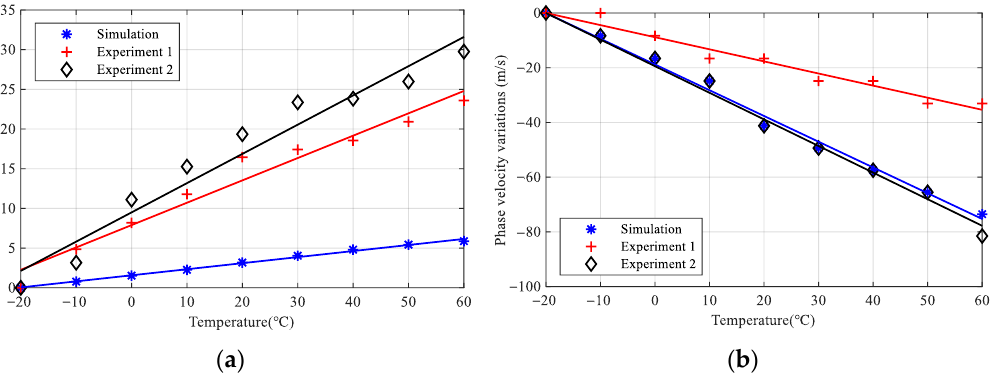
Figure 12. Comparison for variations of S 0 mode between simulation and experiment. ( a ) Variations of amplitude; ( b ) variations of phase velocity.